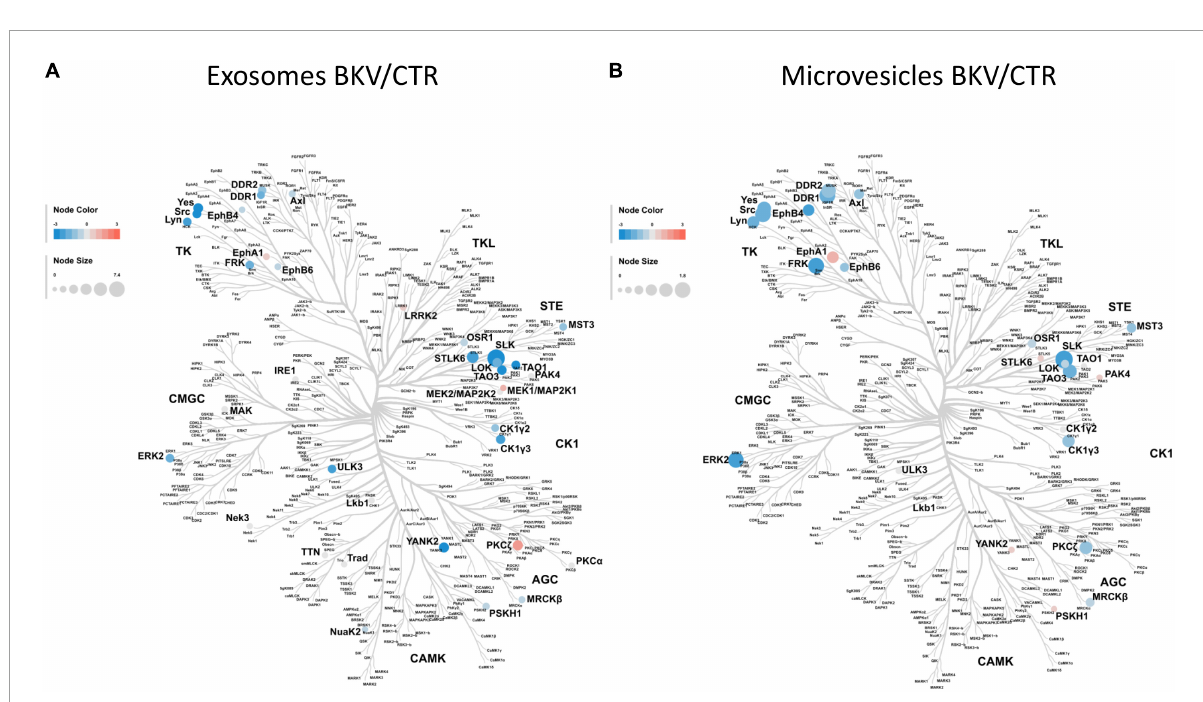
FIGURE3 Kinome profile of microvesicles and exosomes isolated from urine of patients with BKV infection and Control. In these diagrams, featuring a dendrogram of human protein kinases, the log 2 of label-free quantification intensity fold change of each kinase (circle) was converted by a pseudocolor scale with red, blue, and white indicating, respectively, up, down and non-differentially expressed proteins in (A) exosomes and (B) microvesicles isolated from 12 patients with BKV infection and 6 Control. The size of circles was proportional to the corresponding –Log 10 p- value. Kinome profiles showed a significant down-regulation of kinases in patients with BKV infection compared to CTR in both extracellular vesicles. SLK was able to reach the higher level of discrimination between the 2 study groups in both extracellular